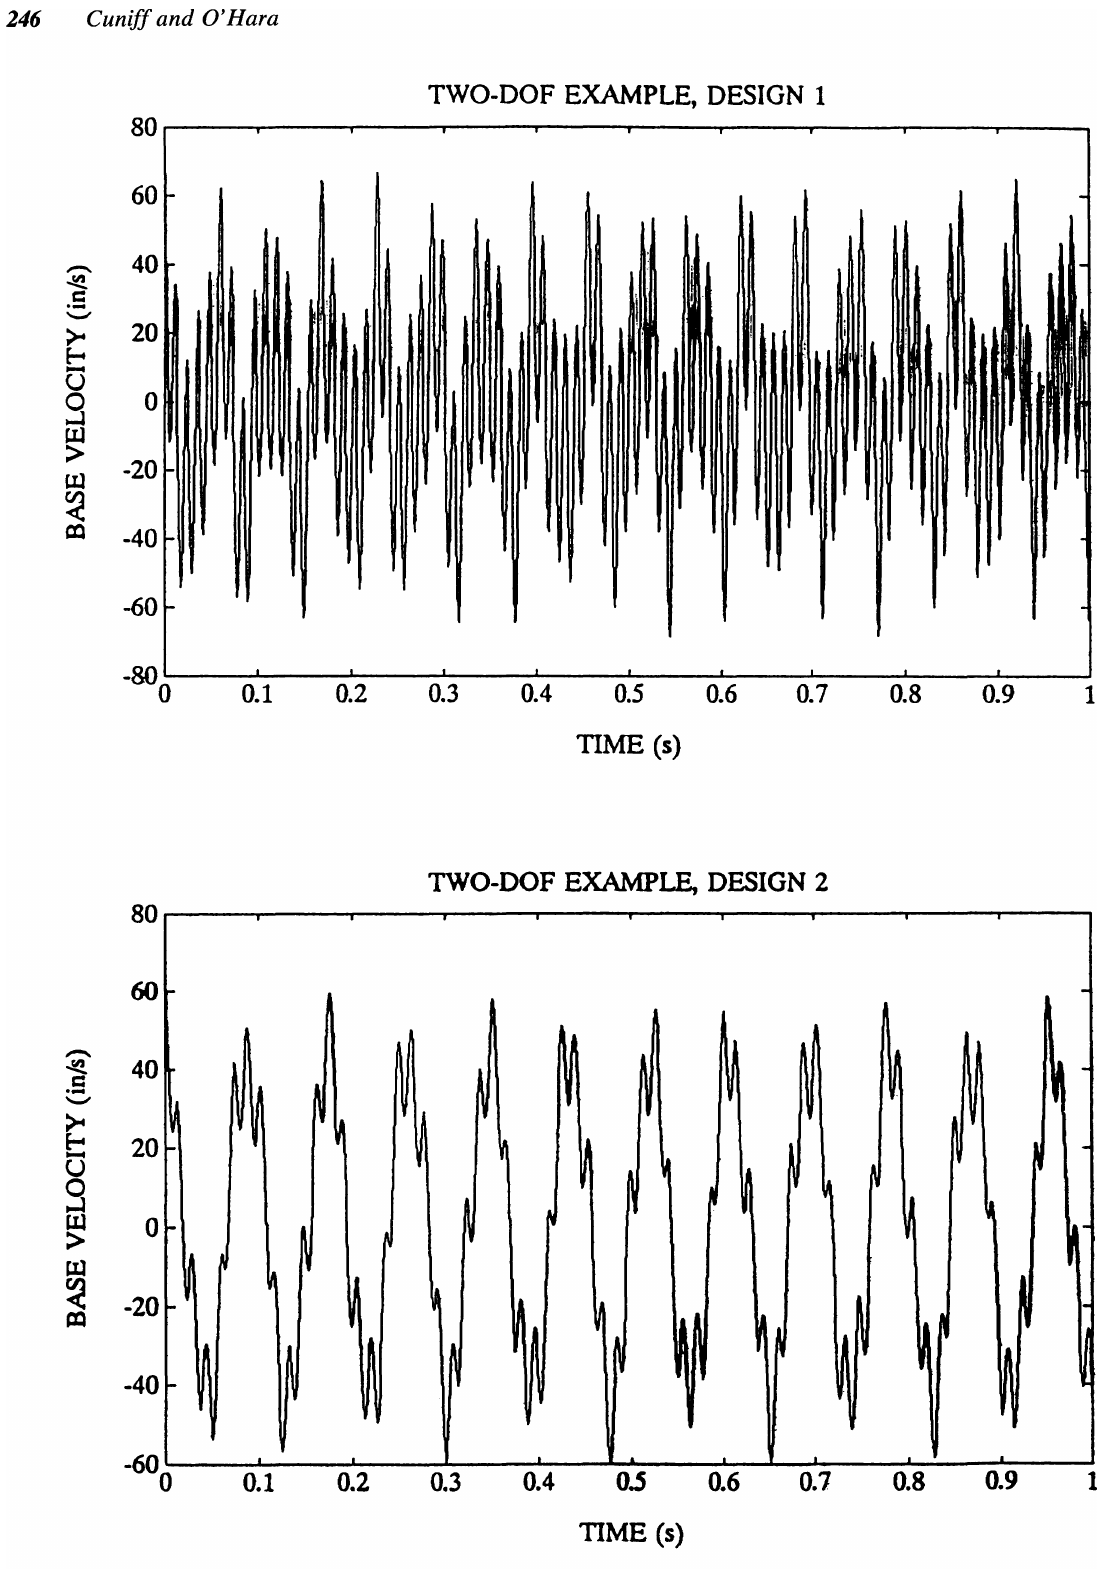
FIGURE 7 Time history motions, base velocity, Design 1 and Design 2, Example